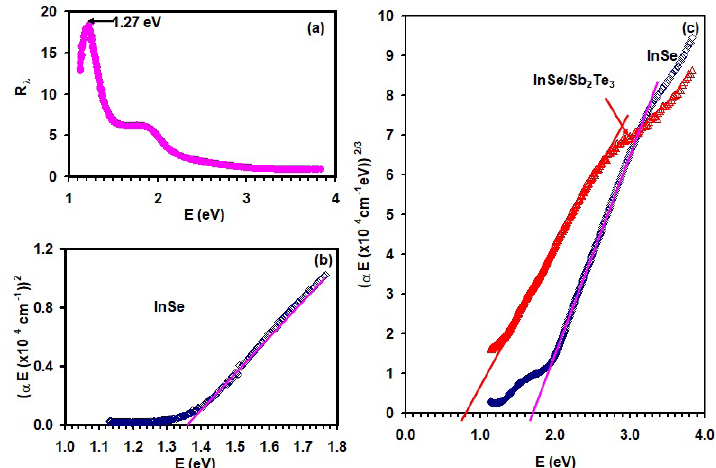
Figure 3. (a) the light absorbability and the Tauc’s equation fittings for (b) InSe in the low absorption region and (c) for InSe and InSe/ Sb Te In the high absorption 2 3